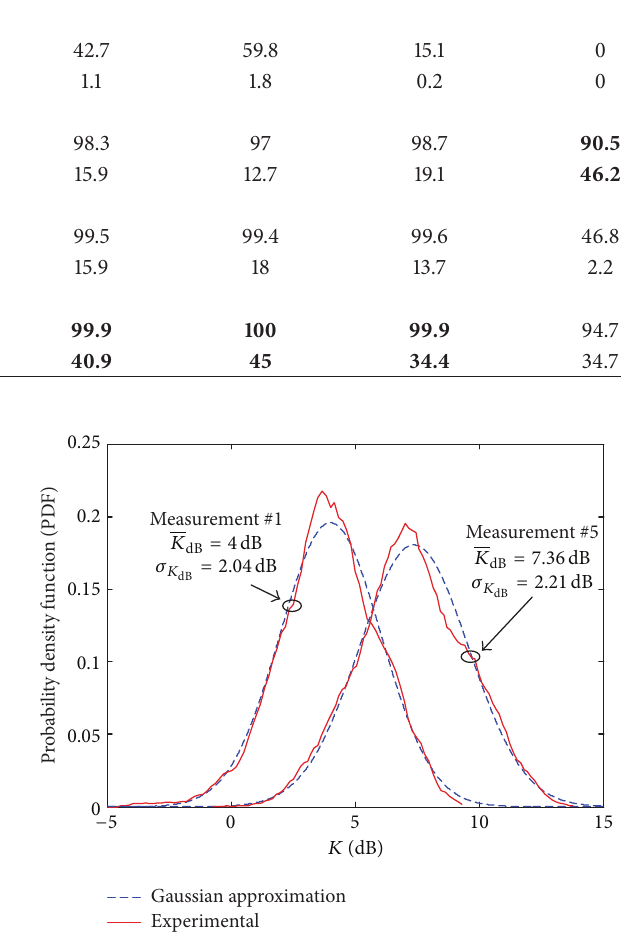
Figure 4: Probability density functions of the Rice 𝐾 -factor in dB and the Gaussian approximation for the measurements #1 and